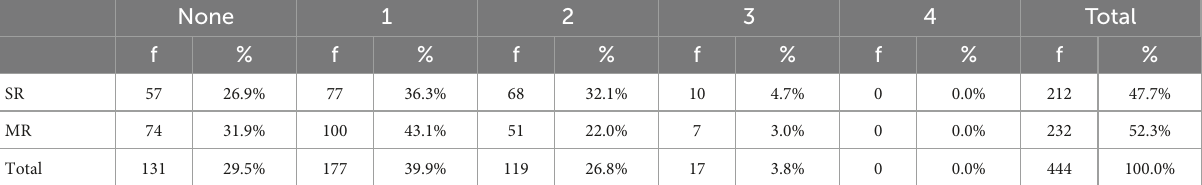
TABLE 6 Frequency and percentage of social regulation episodes with different arousal numbers (from none to four members).